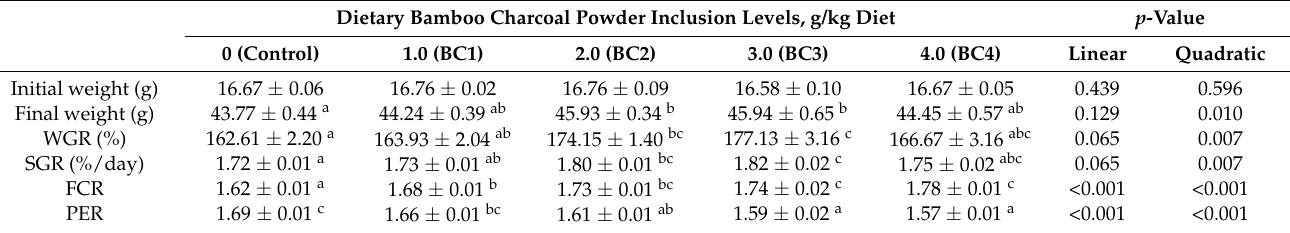
Table 3. Growth performance of blunt snout bream fed with the experimental diets 1 .